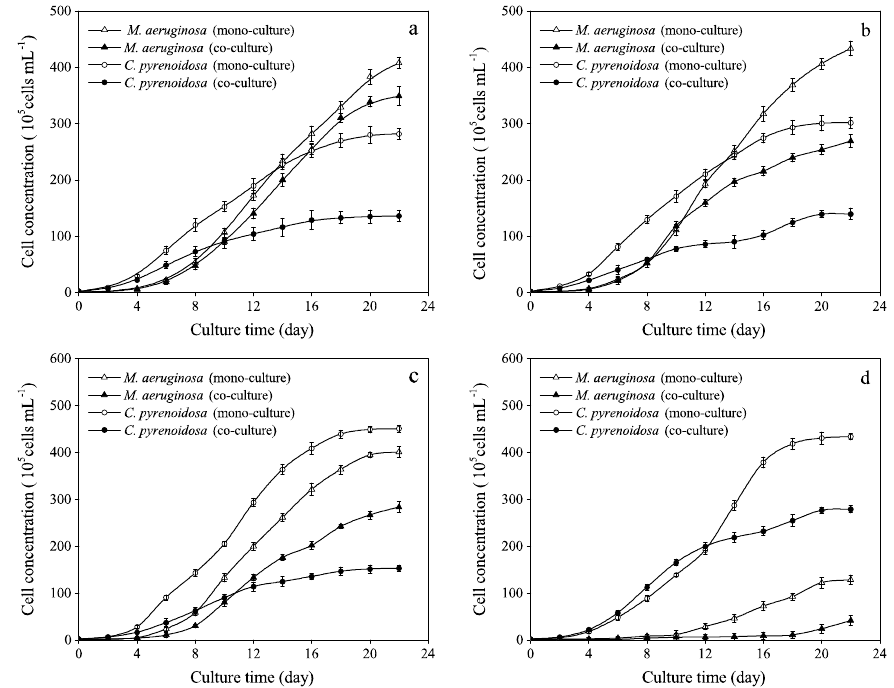
Figure 1. Growth curves of M. aeruginosa and C.pyrenoidosa in mono-cultures and co-cultures under different treatments of phenol: ( a ) 0 μ g mL − 1 , ( b ) 2 μ g mL − 1 , ( c ) 20 μ g mL − 1 , and ( d ) 200 μ g mL − 1 .